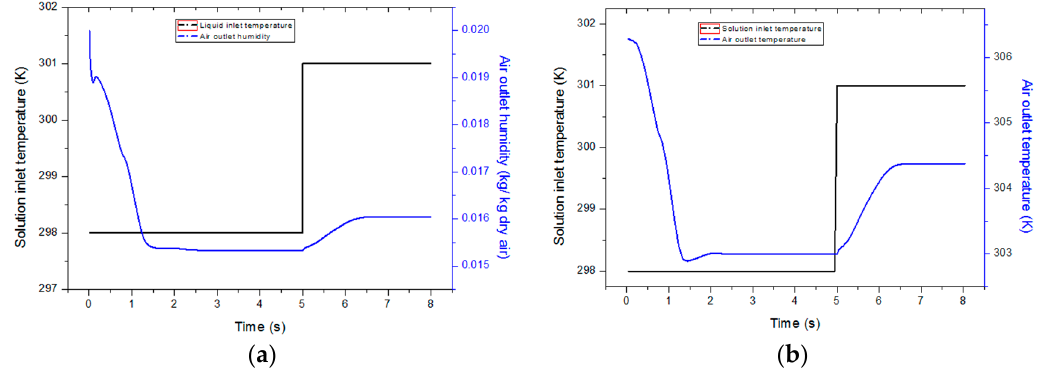
Figure 4. Humidity and temperature variation under step change of solution temperature. ( a ) air outlet humidity; ( b ) air outlet